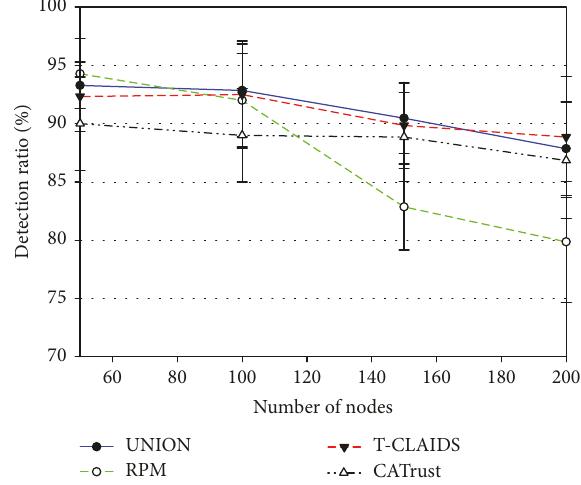
Figure 6: 𝑈𝑁𝐼𝑂𝑁 detection performance compared to 𝑅𝑃𝑀 , 𝐶𝐴𝑇𝑟𝑢𝑠𝑡 , and 𝑇 - 𝐶𝐿𝐴𝐼𝐷𝑆 in the presence of 25% dishonest UAVs.